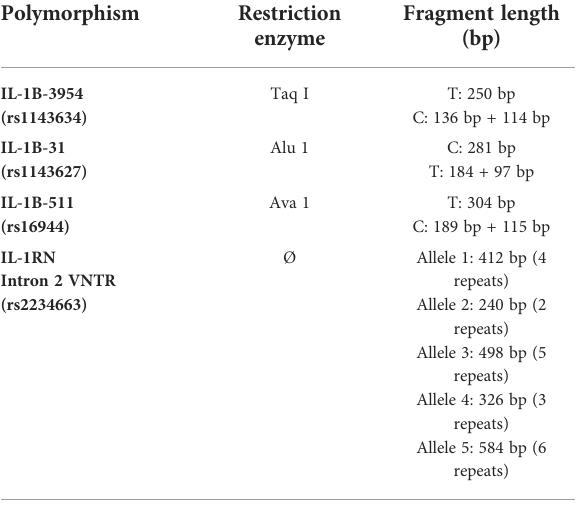
TABLE 2 The analyzed polymorphisms with the respective restriction enzymes and the resulting DNA fragment lengths.